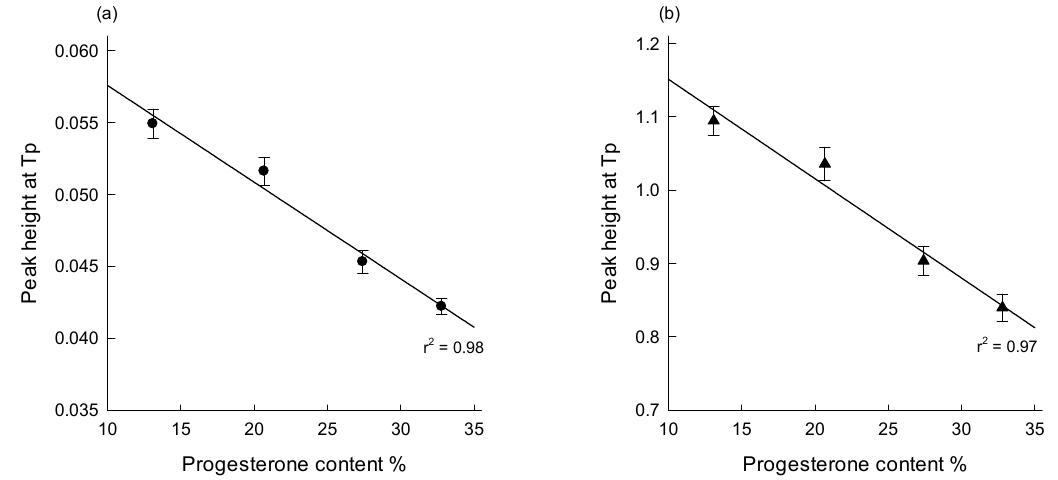
Figure 10. Linear correlation between the peak height at Tp and progesterone payload of microspheres.